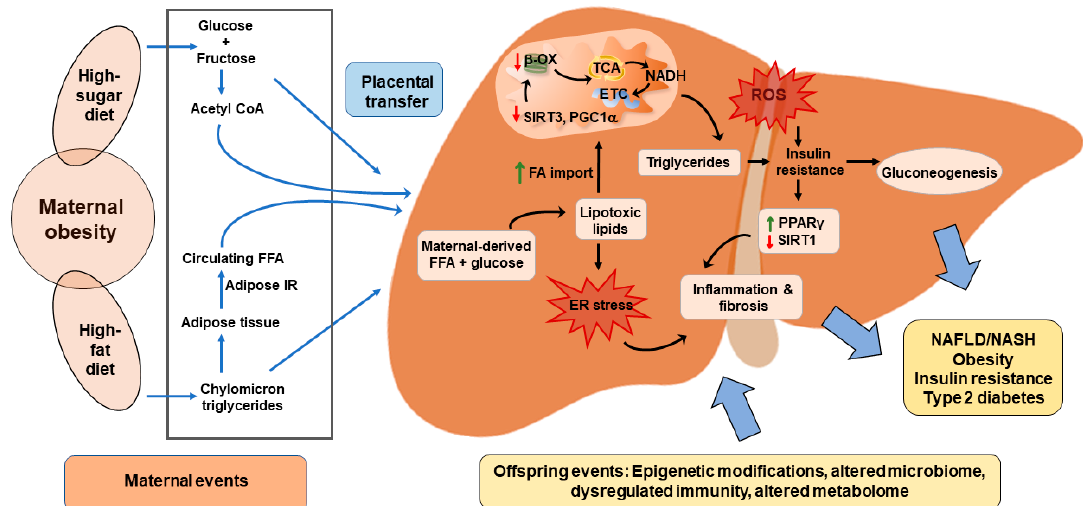
Figure 2. Maternal malnutrition imparts long-lasting detrimental effects on offspring liver. Placental transfer of excess circulating free fatty acids (FFA) and carbohydrates from obese mother induces mitochondrial dysfunction and endoplasmic reticulum (ER) stress. The resulting mitochondrial dysfunction predisposes the offspring liver to reduced lipid peroxidation by decreasing SIRT3 and PGC1 α expression, oxidative stress, inflammation, insulin resistance (IR), and increased gluconeogenesis leading to the development of NAFLD. In utero exposure to an obesogenic environment also induces early microbial dysbiosis, leading to the reprogramming of offspring liver towards an inflammatory phenotype by epigenetic modifications. β -OX, beta oxidation; ETC, electron transport chain; ROS, reactive oxygen species; TCA, tricarboxylic acid.